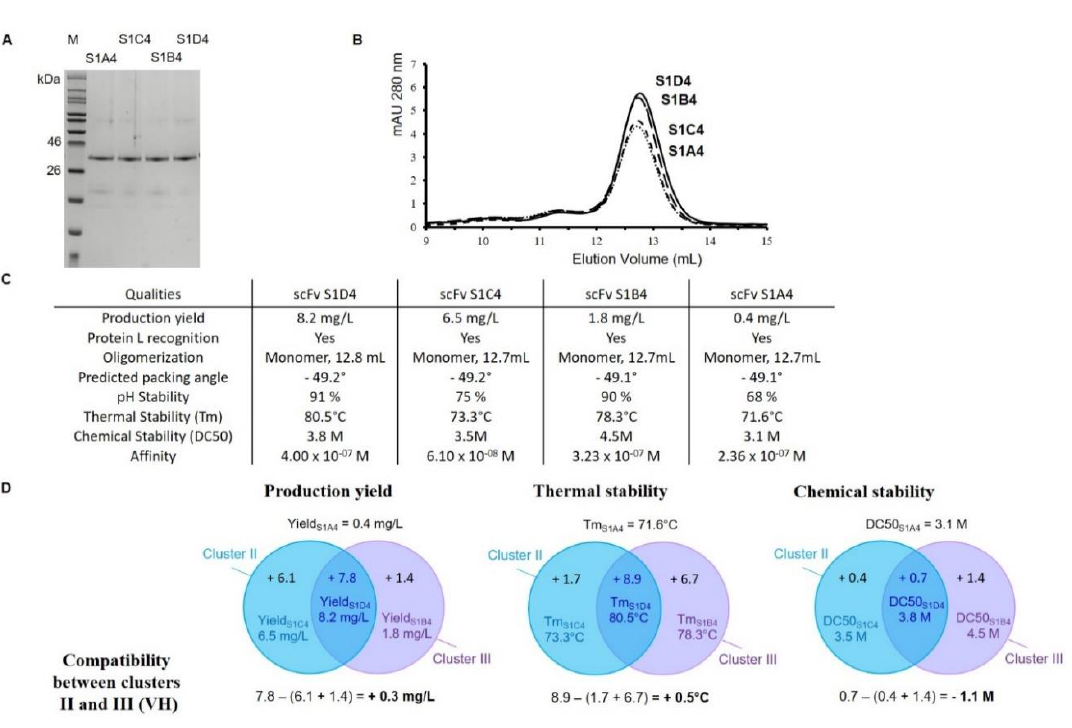
Figure 5. Structural and functional characterization of the scFvs S1D4, S1C4, S1B4 and S1A4. ( A ) SDS- PAGE analysis of purified scFv variants under reducing conditions. M: Molecular marker. ( B ) Analytical Size-exclusion chromatography (SEC) chromatogram on a calibrated Superdex 75 10/300 GL column of the purified scFv variants: scFv S1D4 (solid line), scFv S1B4 (long dashed line), scFv S1C4 (short dashed line) and scFv S1A4 (dotted line). ( C ) Production yield and biophysical properties of the three analyzed scFvs. ( D ) Venn diagram for analysis of production yield, thermal stability